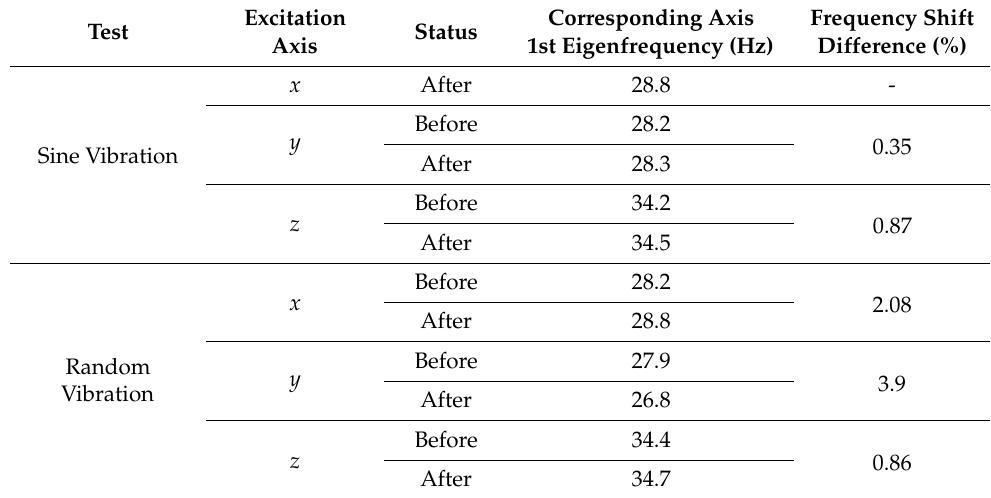
Table 6. Results of the WSVI’s Low Level Sine Sweep (LLSS) Tests Conducted before and after the Launch-vibration